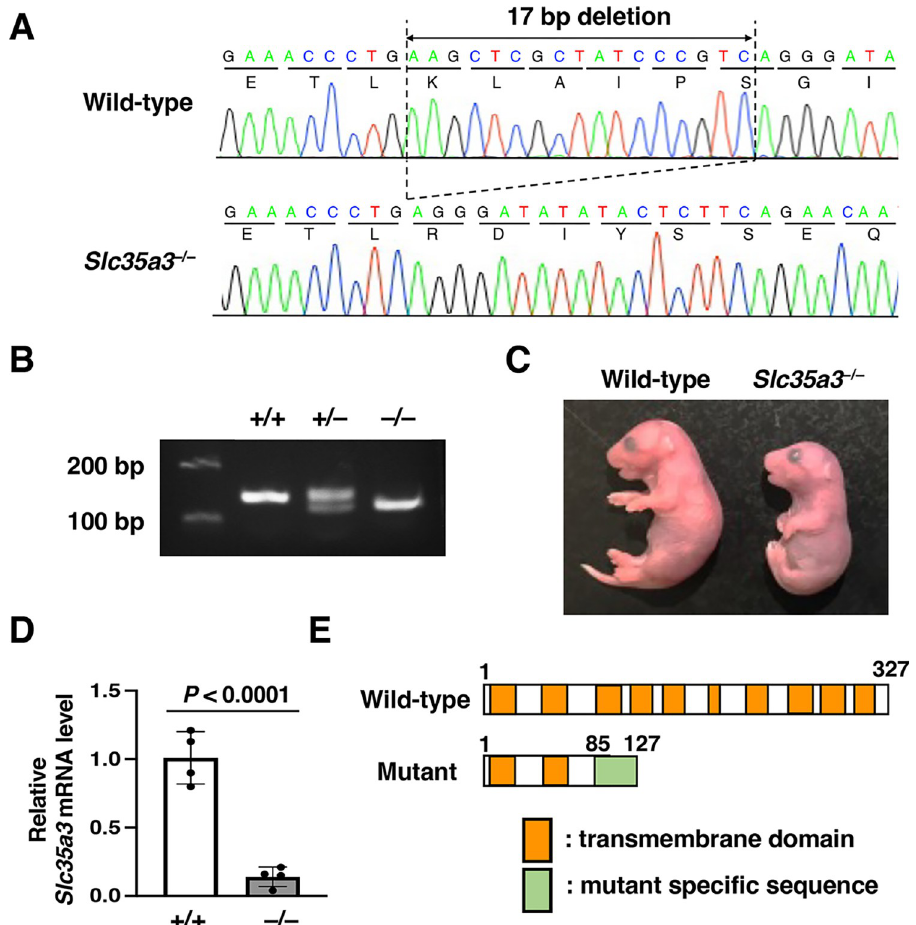
Fig 1. Generation of Slc35a3 –/– mice using genome editing. (A) Sequence chromatograms of the edited genomic region in exon 3 of the Slc35a3 gene. A homozygous 17-bp deletion (c.255_271del) leading to frameshift occurred in Slc35a3 –/– mice. (B) Agarose gel electrophoresis image of PCR products used for genotyping. +/+: wild-type; +/ − : Slc35a3 +/ − ; − / − : Slc35a3 −/− . Upper band: wild-type allele-specific PCR products; lower band: 17-bp deletion allele- specific PCR products. (C) Gross appearance of wild-type and Slc35a3 −/− littermate embryos at E18.5. (D) Relative Slc35a3 mRNA expression in the limbs of wild-type (+/+) and Slc35a3 –/– mice ( − / − ). Data are shown as means ± standard deviation (n = 4). P values were calculated using Student’s t -test. (E) Structural comparison of wild- type and mutant SLC35A3 proteins. The wild-type SLC35A3 protein consists of 327 amino acids with 10 predicted transmembrane domains, whereas the mutant protein consists of 85 SLC35A3-specific amino acids with 2 transmembrane domains and 42 mutant specific amino